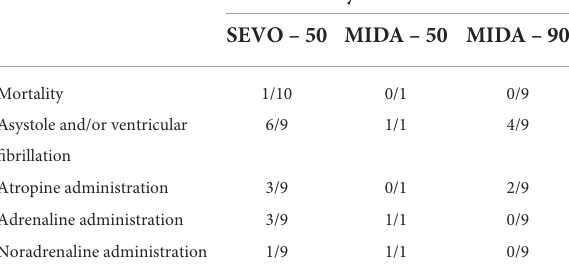
TABLE 2 Mortality, events, and inotrope administration during AMI